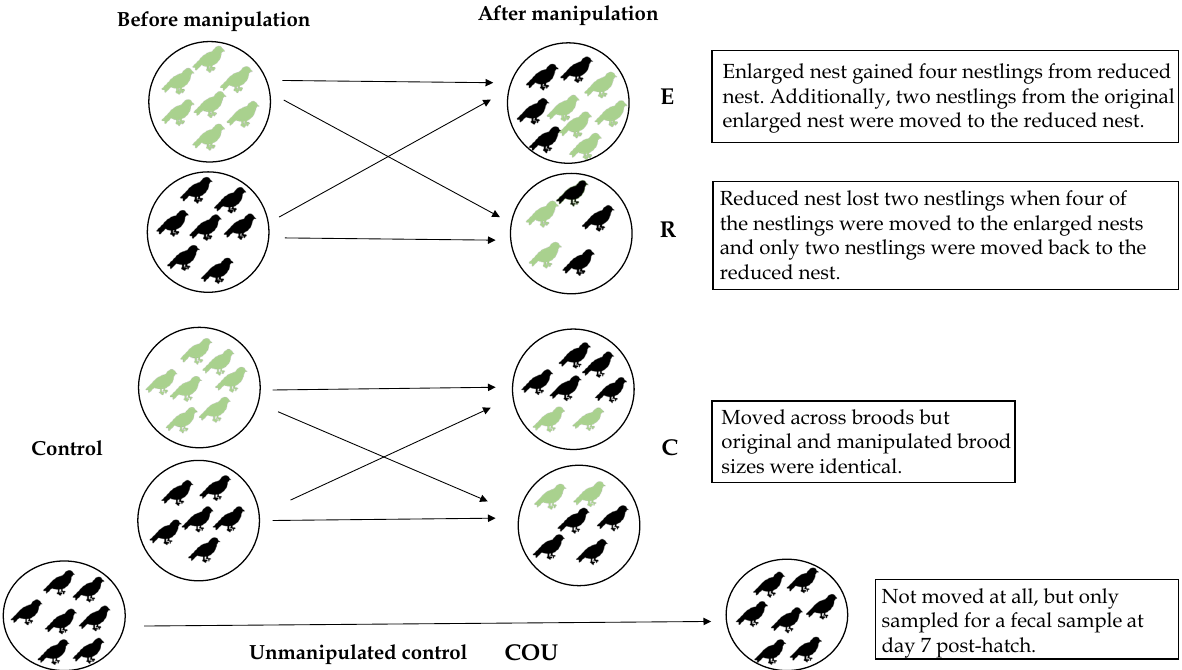
Fig. 1 Brood size manipulation experiment schematic diagram. 2‑day‑old nestlings were moved between nestboxes to enlarge or to reduce original brood size (an example with brood size of seven is given). Some nests were kept as control nests (nestlings were moved but brood size remained the same) and some were kept as unmanipulated control nests (nestlings were not moved at all to test whether early‑life handling affects gut microbiome). The original brood size varied between